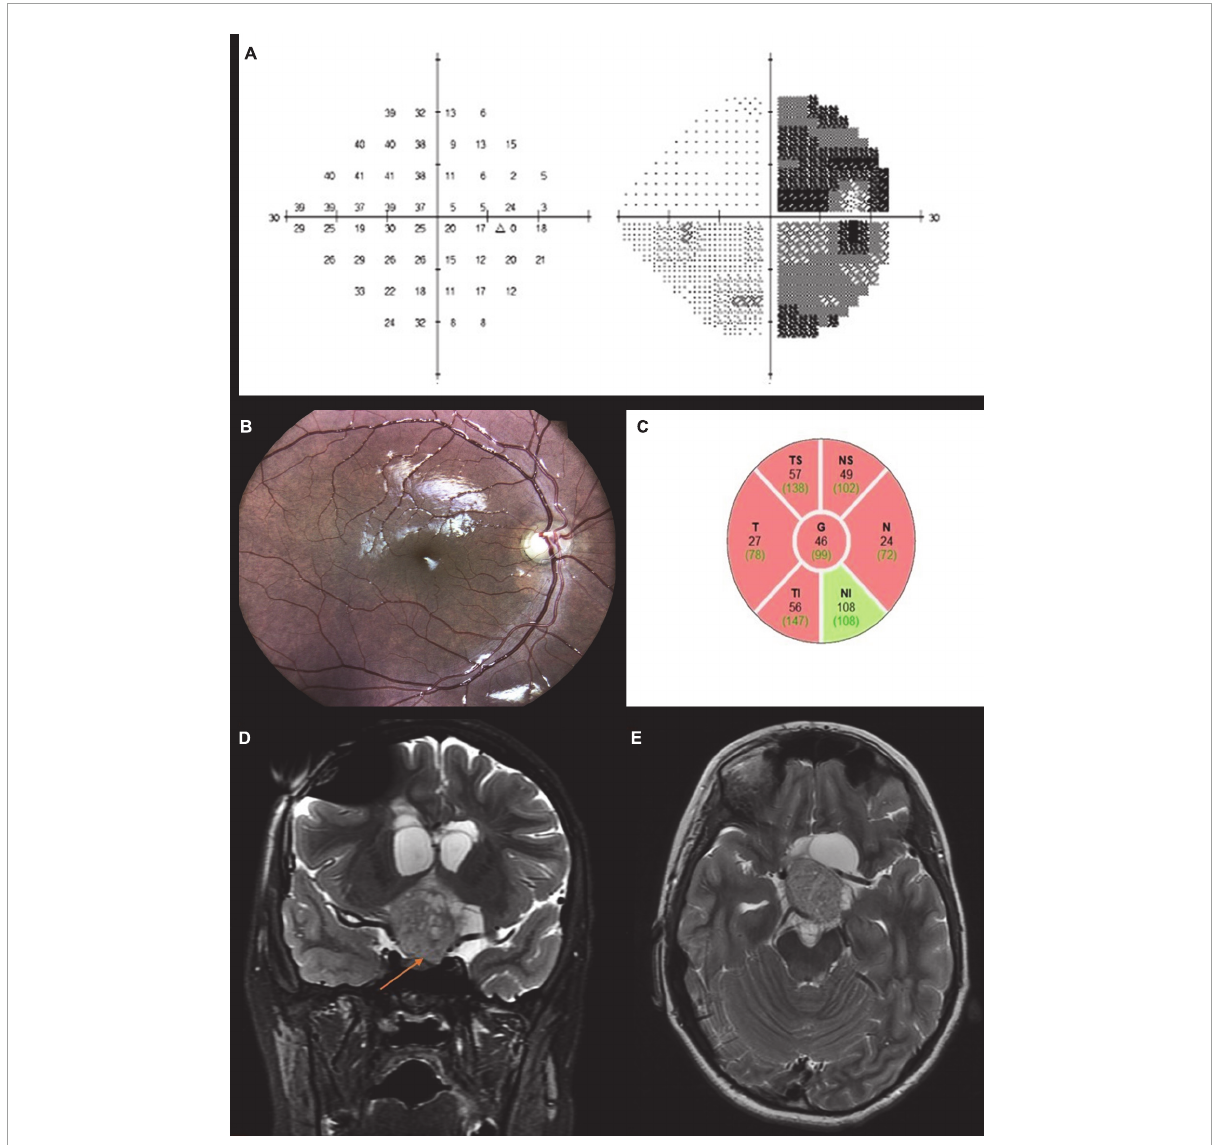
FIGURE4 Case 4. Automated perimetry demonstrating temporal hemianopia in the right eye (A) . Brain MRI T2 coronal (B) and axial images (C) showing a large chiasmatic lesion extending to the left optic tract and left pre chiasmatic optic nerve causing compression of the third ventricle. Fundus color photograph shows bow tie atrophy of the right optic disc (D) . OCT scan of the right eye showing diffuse RNFL thinning (E)